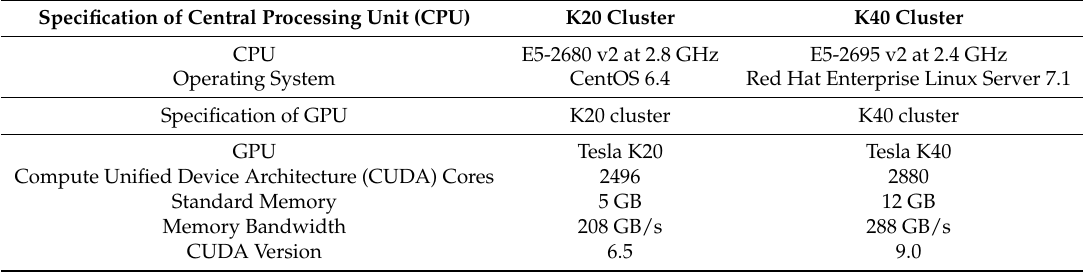
Table 1. Configurations of graphics processing unit (GPU) clusters.